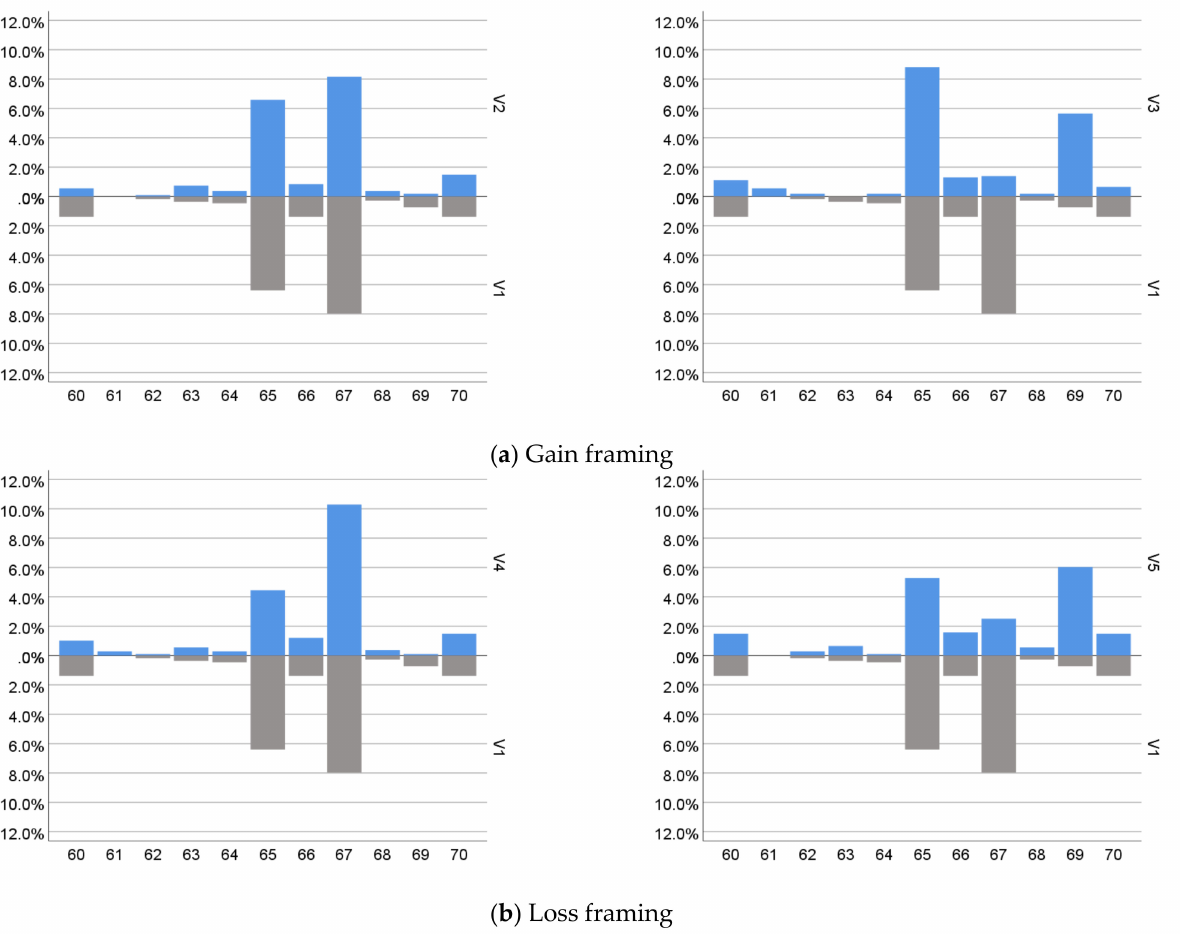
Figure 1. The impact of the framing effect on the retirement age. ( a ) Gain framing; ( b ) Loss